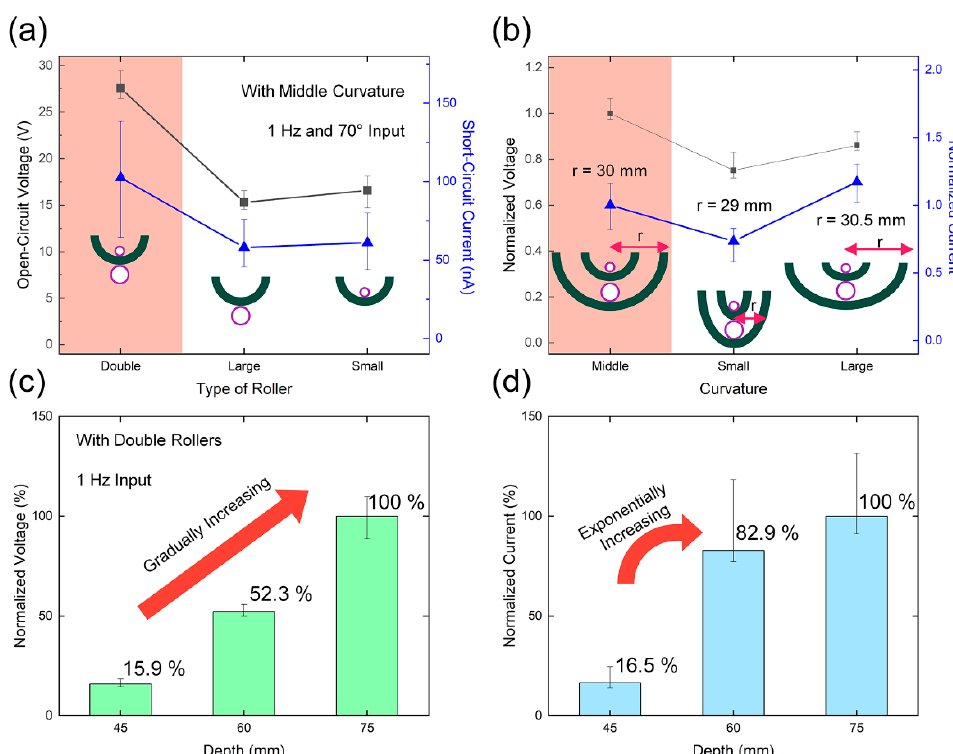
Figure 3. Structural optimization of the fabricated DR-TENG from electrical output characteristics. ( a ) Open-circuit voltages ( V OC s) and short-circuit currents ( I SC s) from the three cases, with double rollers, only one large roller, and only one small roller. ( b ) V OC s and I SC s with the three different curvatures. ( c , d ) Normalized electrical outputs with three different depths.